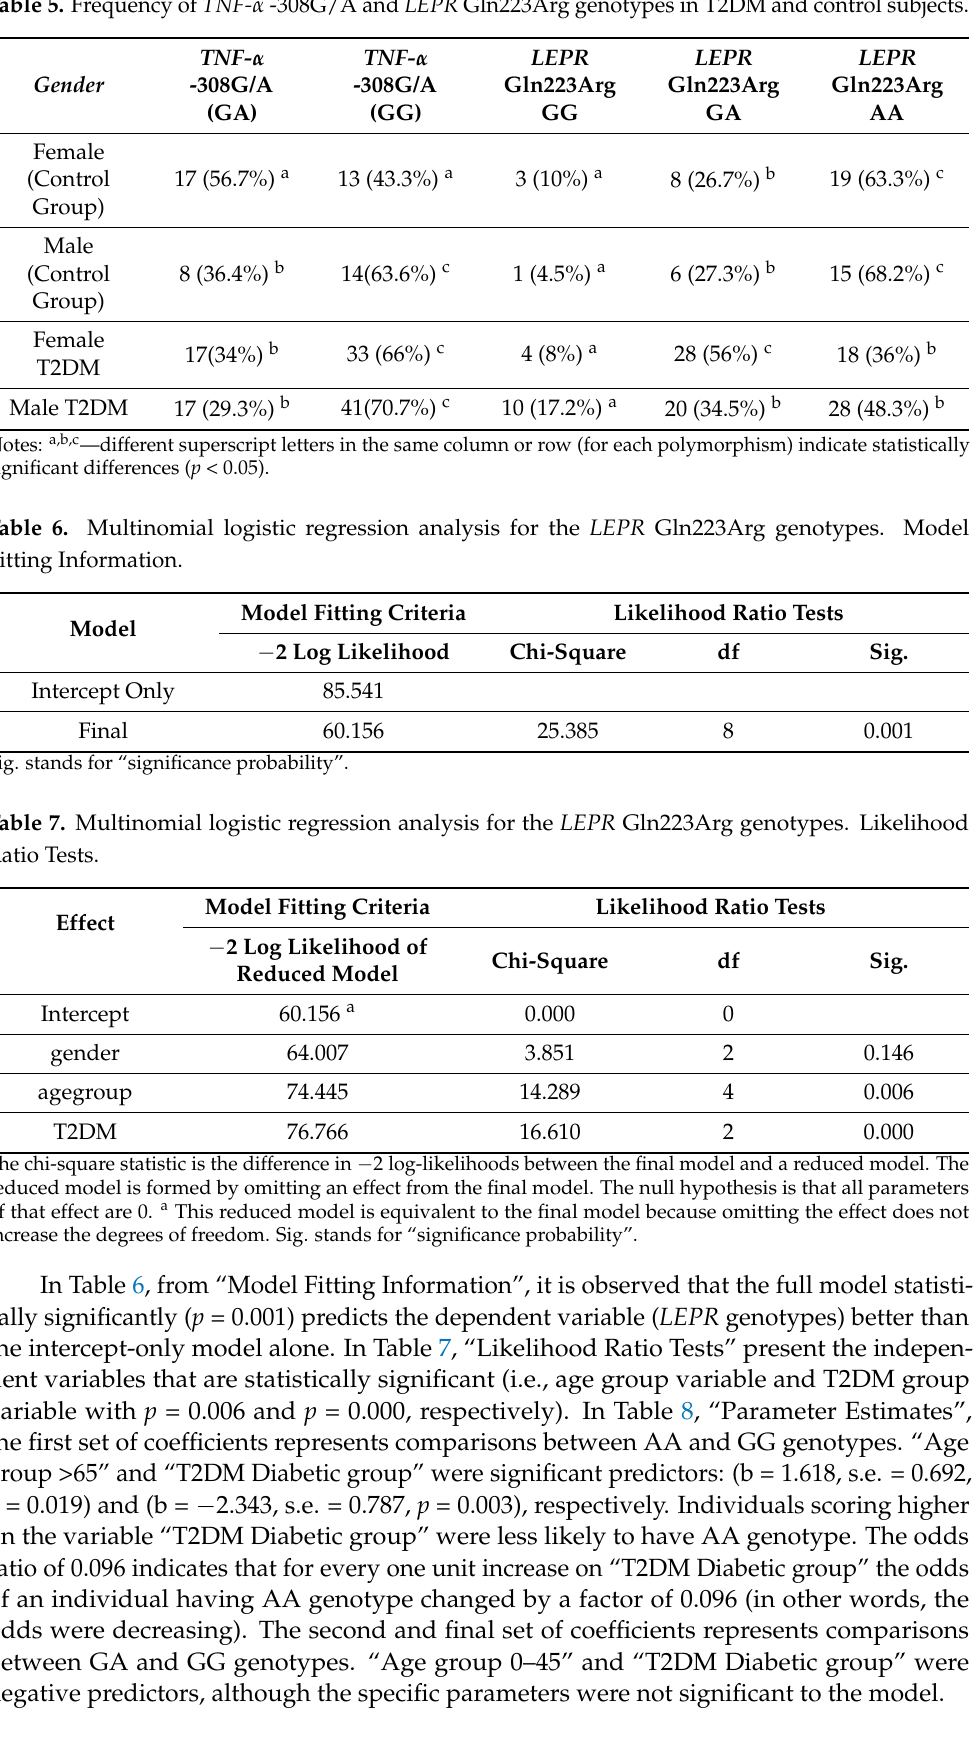
Table 5. Frequency of TNF- α -308G/A and LEPR Gln223Arg genotypes in T2DM and control subjects.